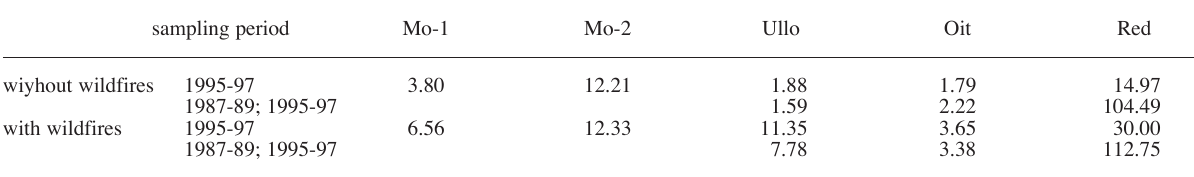
results (Table 2) of flow data for the three rivers: Mo-1, Ullo and Oitabén show high R values while upon correlating suspended matter, the River Mo-2 and the River Red show a distinct behaviour when compared to the rest of the rivers, with whom they share low total percentage variance. Additionally, the R values for the flows remain constant when the observation period is prolonged using data from 1987-89, while the R values for suspended matter in the River Red when compared with the remaining rivers show big oscillations upon modifying the observation period. This means that although all rivers show a response to the rainfall pattern, each river has its own characteristic response for sus- pended matter which distinguishes it from the rest.